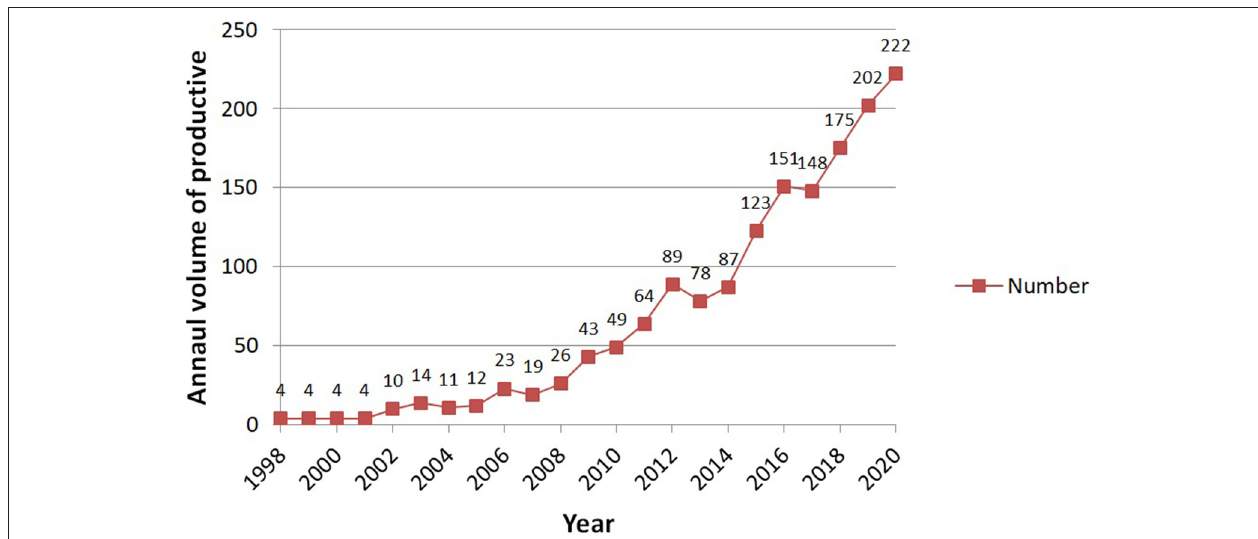
FIGURE 2 | The annual volume of